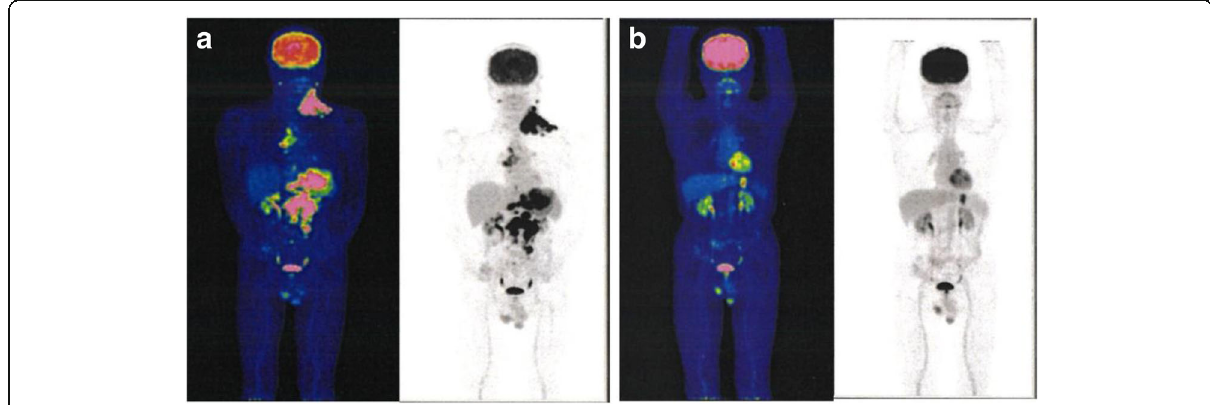
Fig. 1 18 F-fluorodeoxyglucose positron emission tomography findings. 18 F-fluorodeoxyglucose positron emission tomography prior to treatment a in October 2009 and b in June 2011, following 2 years of chemo-immunotherapy. The metabolic values of the deposits in the lesions (such as left supraclavicular lymph nodes) other than the stomach decreased markedly or disappeared. The deposit in the stomach lesion and the sizes of all the lesions decreased markedly, compared with the sizes prior to